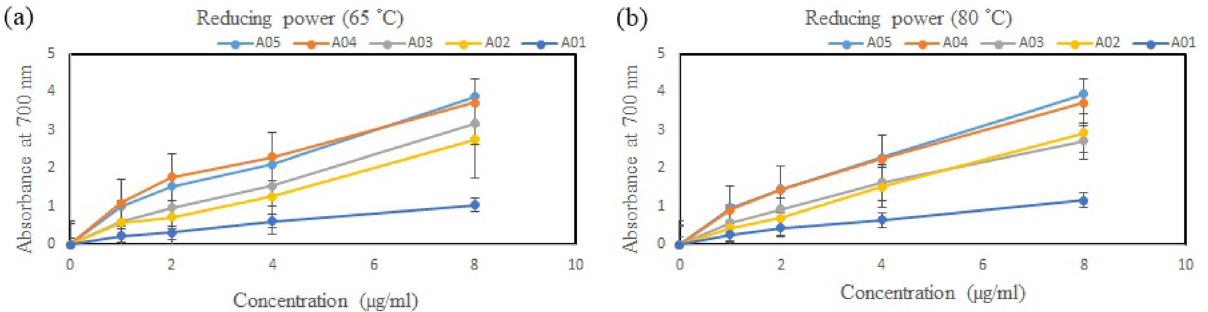
Figure 5. Reducing power of fucoidan obtained from S. ilicifolium at different locations that was extracted at ( a ) 65 °C and ( b ) 80 °C. Bars indicate SD, n = 3.